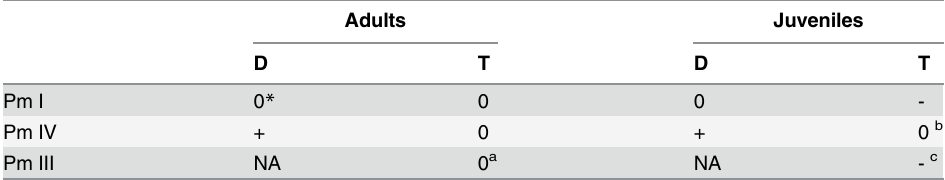
Table 3. Overview of the effect of the interspecific interactions on the